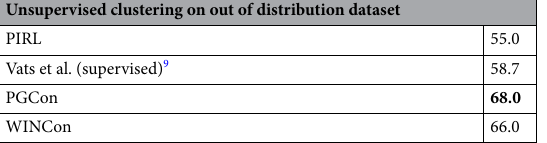
Table 2. Top-1 accuracies using weighted kNN-classifier over out-of-distribution samples from CAD- CAP data to obtain an estimate for inherent discrimination and generalization to new classes. Clustering is performed over normalized 128-dimensional z i p embedding from R50 encoder. To our surprise, PGCon and WINCon outperforms fully supervised classification on CAD-CAP data 9 . Significant values are in bold.